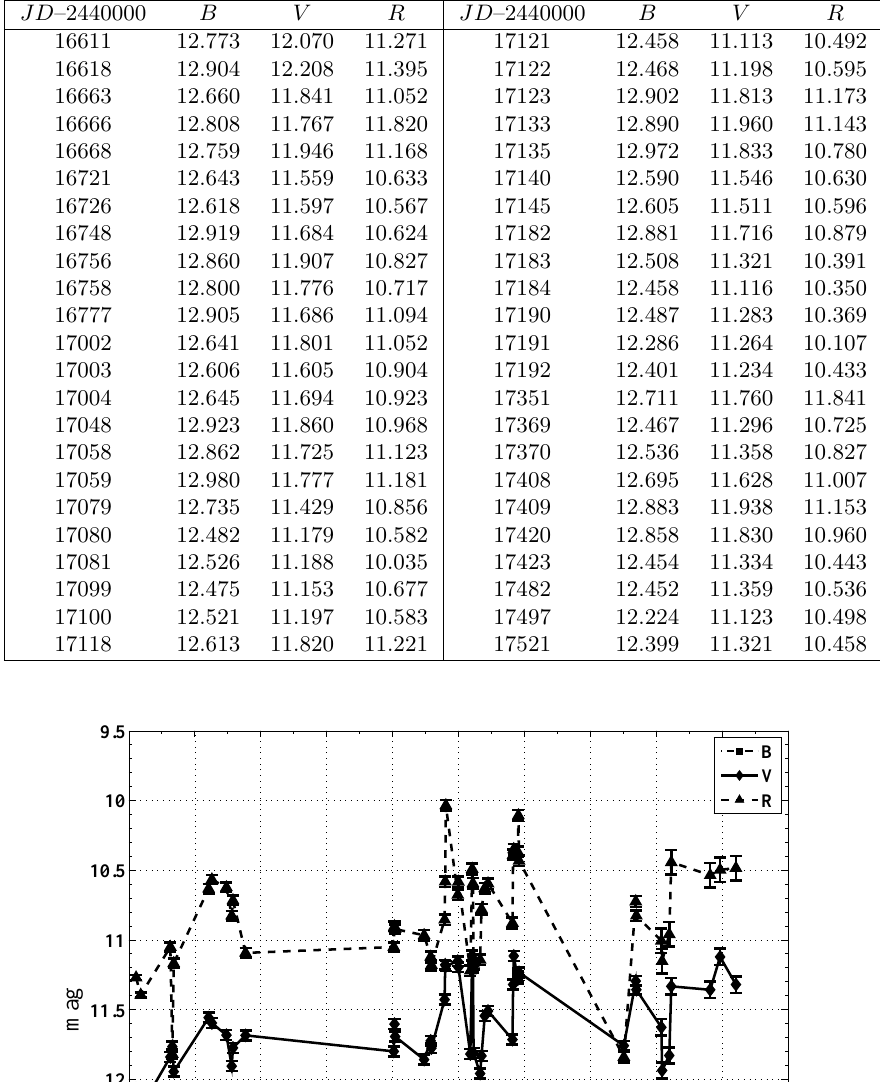
Table 1. BV R photometry of the galaxy NGC 4151.